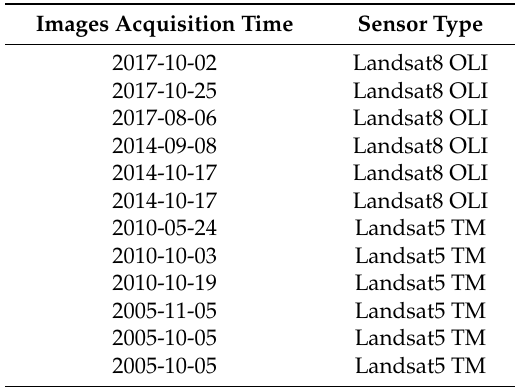
Table 1. Multitemporal images and sensors information table.